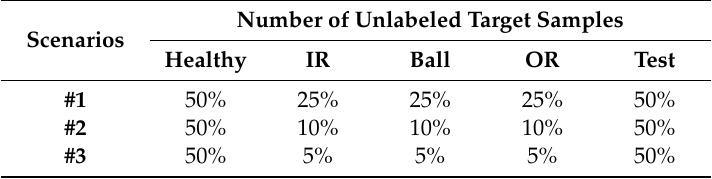
Table 5. Details of the imbalanced target dataset used in case 2 of this experiment.